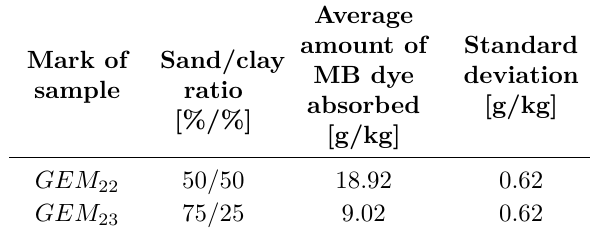
Table 5. Amount of MB dye absorbed by earth sam- ples during methylene blue test with defined stirring time.